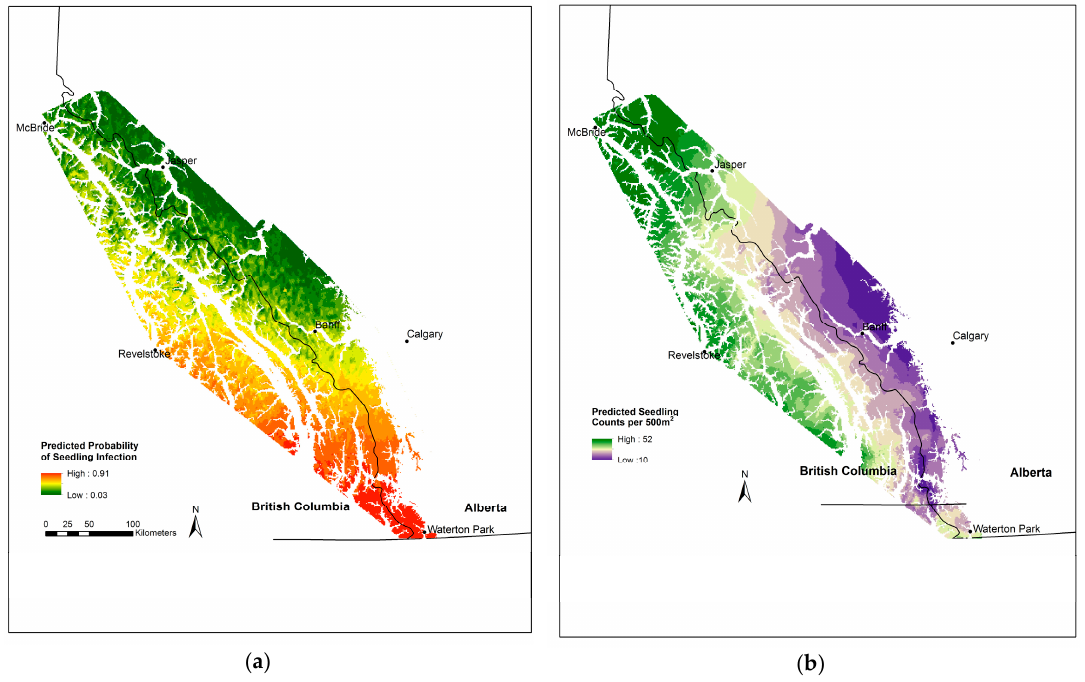
Figure 9. Predicted probability of infection for tall seedlings (greater than 50 cm) ( a ) and predicted whitebark natural regeneration (counts of seedlings/500 m 2 ) for plots on south-west aspects based on the average plot-level canopy kill of 20% ( b ). Maps were based on predictions for 2014 using quantile classification with 10 bins of predictions for trees nested in plots. Areas below 1579 m were clipped from the map consistent with our lowest elevation study